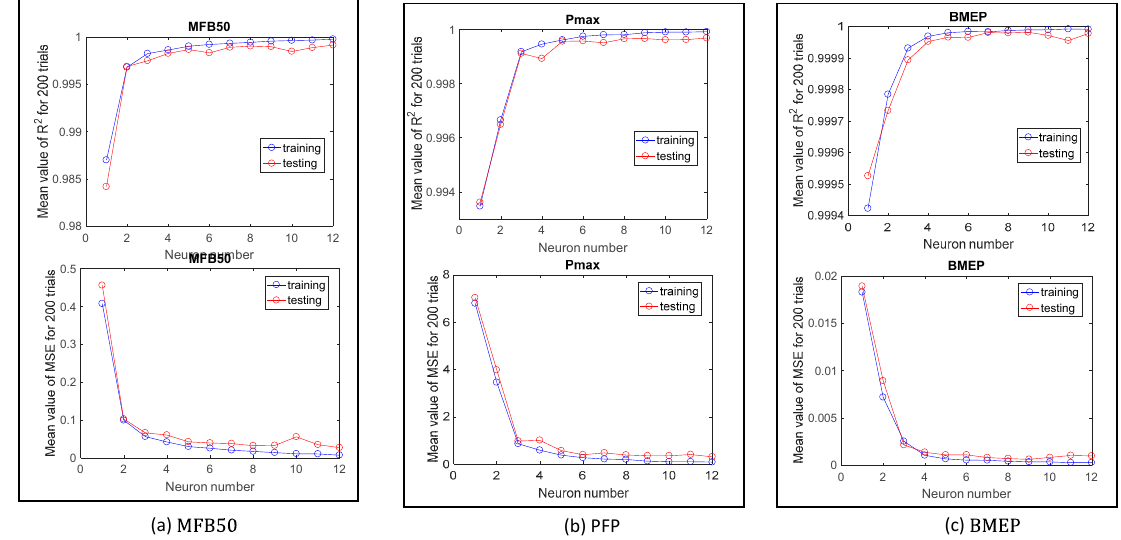
Figure A6. ( a – c ) Mean value of R 2 and MSE over 200 training trials for the ANNs that simulate MFB50 ( a ), PFP ( b ) and BMEP ( c ) combustion metrics, as a function of the number of neurons.